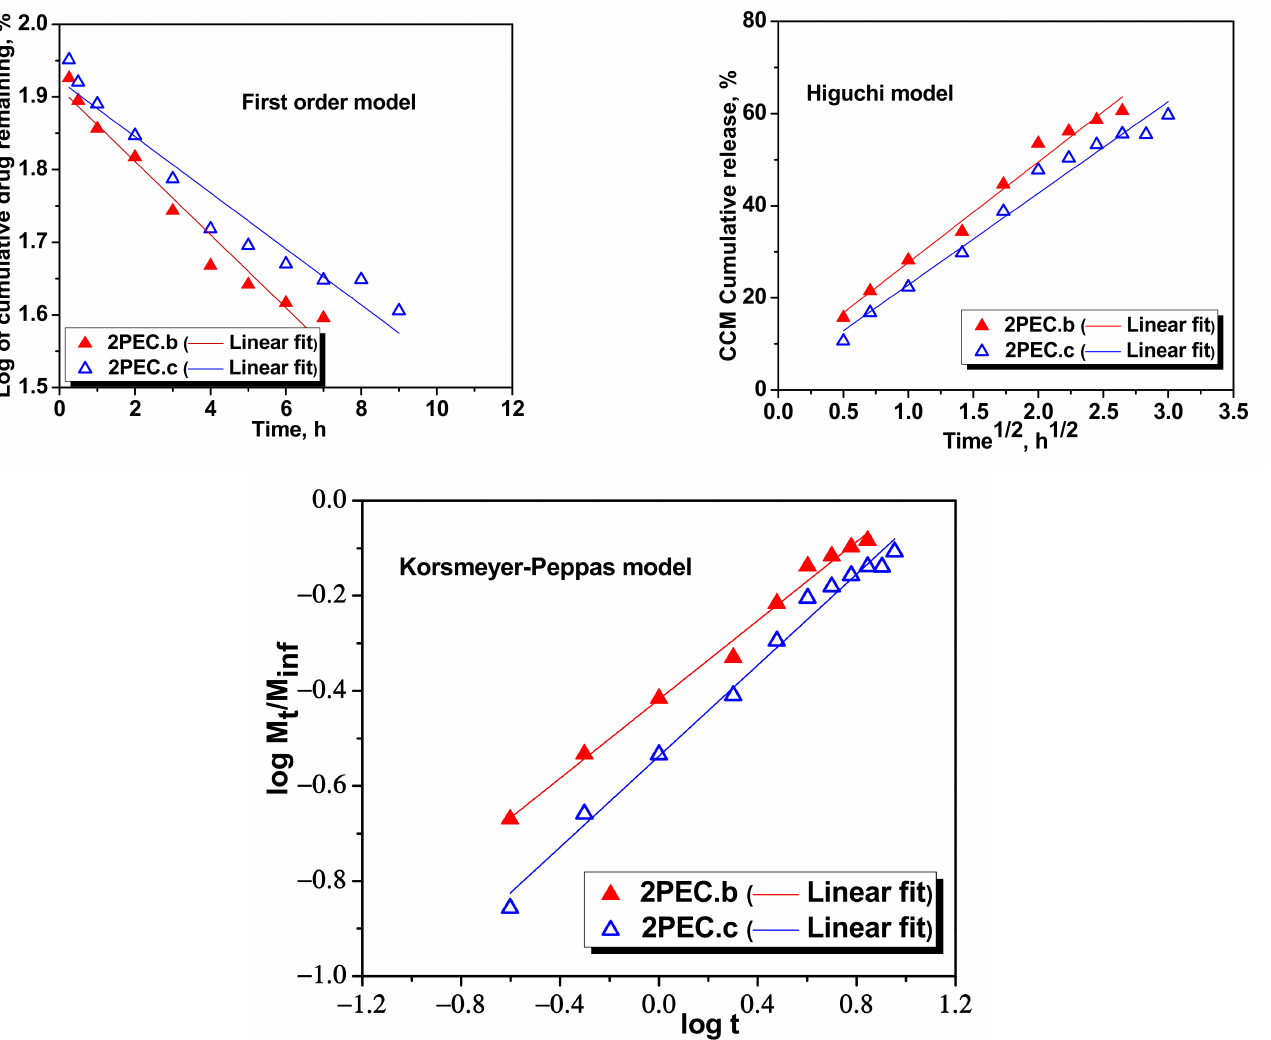
Figure 10. Fitting of kinetic models for the CCM release from 2PEC.b and 2PEC.c